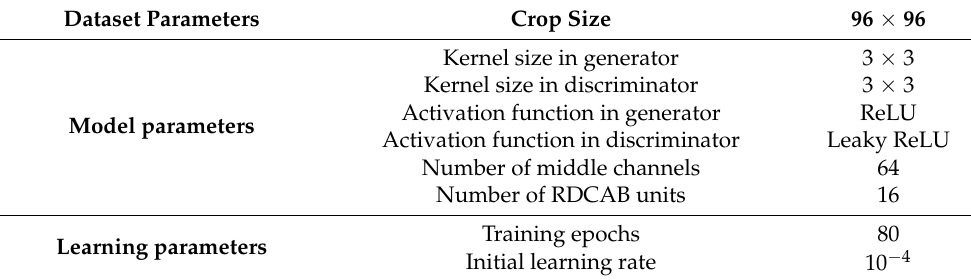
Table 1. DCA-GAN network parameters. Dataset Parameters Crop Size